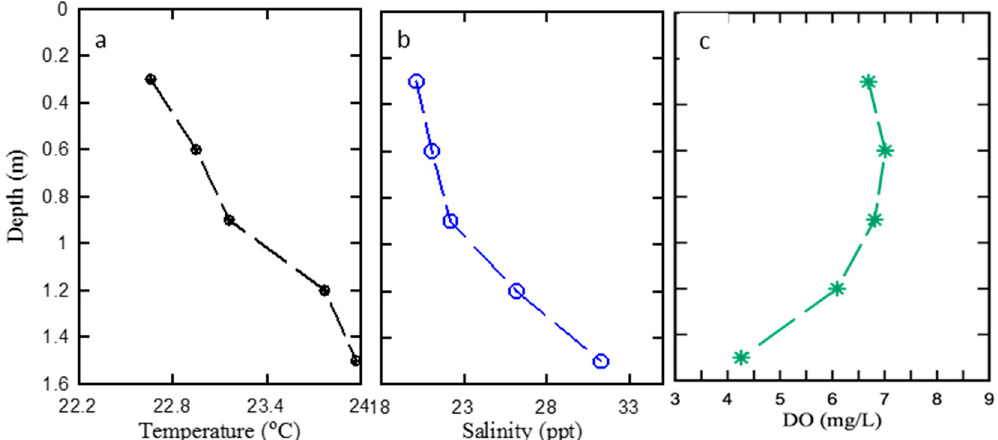
Figure 6. Vertical profile of the physiochemical properties of Currimundi Lake during the closed state E2, 9 September 2015 at the Pontoon (Figure 1). ( a ) Temperature, ( b ) Salinity, ( c ) Dissolved oxygen.